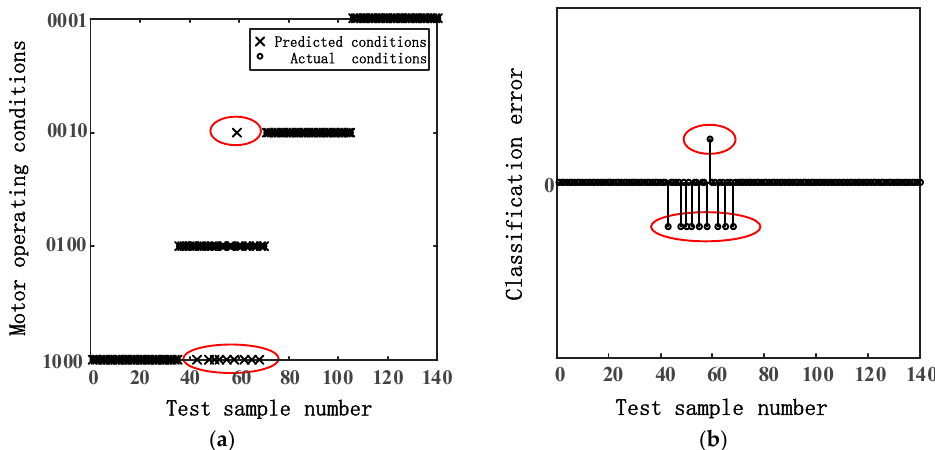
Figure 10. The results of motor fault pattern recognition. ( a ) Classification results; ( b ) classification error. Table 4. Accuracy of motor pattern recognition.